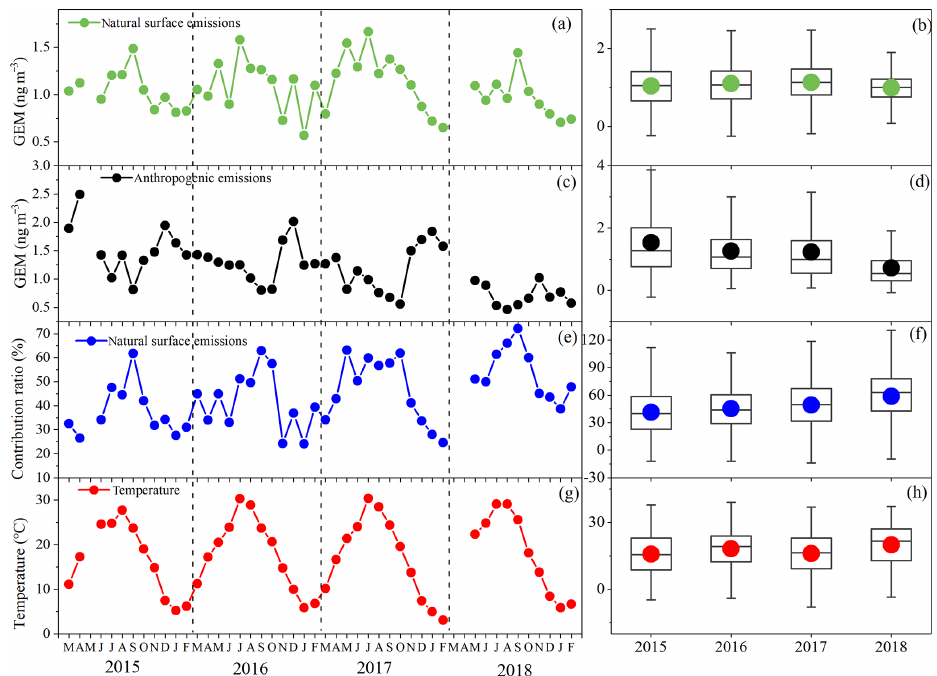
Figure 7. The monthly and annual GEM concentrations contributed by (a, b) natural surface emissions and (c, d) anthropogenic emissions from 2015 to 2018. (e, f) The monthly and annual contribution of natural surface emissions to GEM concentrations from 2015 to 2018. (g, h) The corresponding ambient temperature from 2015 to